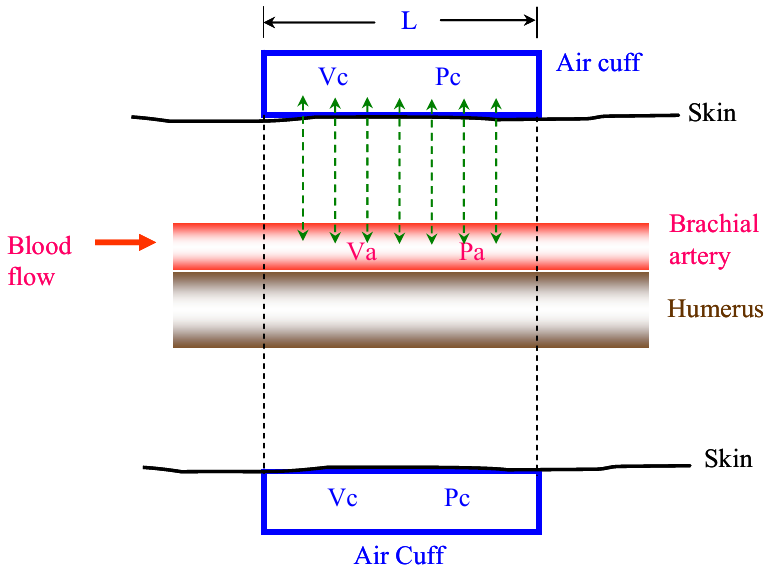
Figure 1. Schematic diagram of an air cuff bladder wrapped around an upper arm. V a and P a are the volume and pressure inside the brachial arterial segment L, and V c and P c are the volume and pressure of the cuff bladder, respectively.